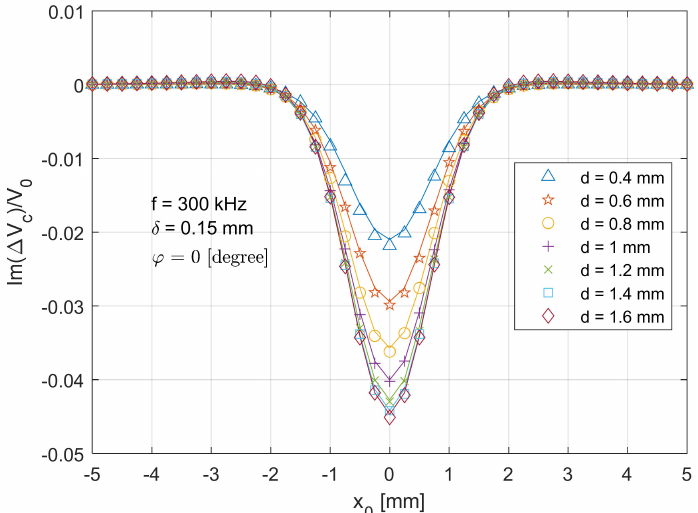
Figure 6. Comparison of analytical (lines) and experimental (markers) results for the imaginary part of normalised voltage change (due to the crack) for the T-R sensor (tilt angle ϕ = 0 degree ) scanning across ( x direction in Figure 2) and through the crack centre.